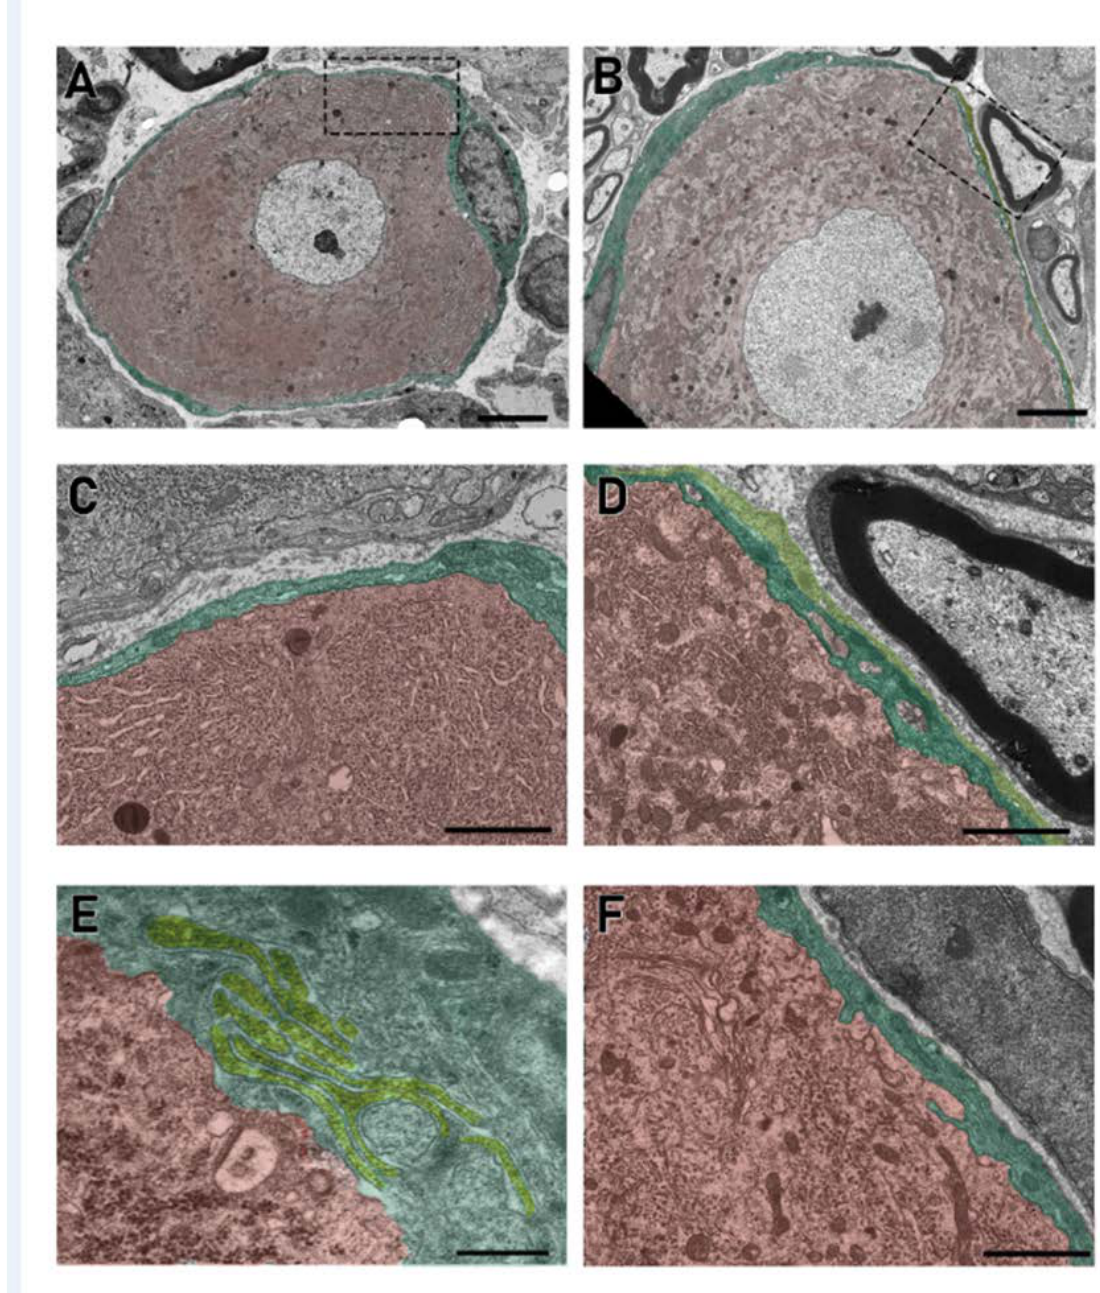
Figure 3 . Electron microscopy analysis of the DRG cells. ( A , C ): vehicle; ( B , D – F ): paclitaxel. Pictures show the different interactions between SGCs and neurons. Computer-aided virtual colors help in the visualization of different SGCs (yellow and green) and neurons (red). ( D ): Two SGCs (dark and light green) wrap the same neuron (red). ( E ): An example of different SGCs membrane projections generating a complex contact internal system (light green). ( A , B ) bar: 5 µm; ( C , D ) bar: 2 µm; ( E ) bar: 0.5 µm; ( F ) bar: 2 µm.